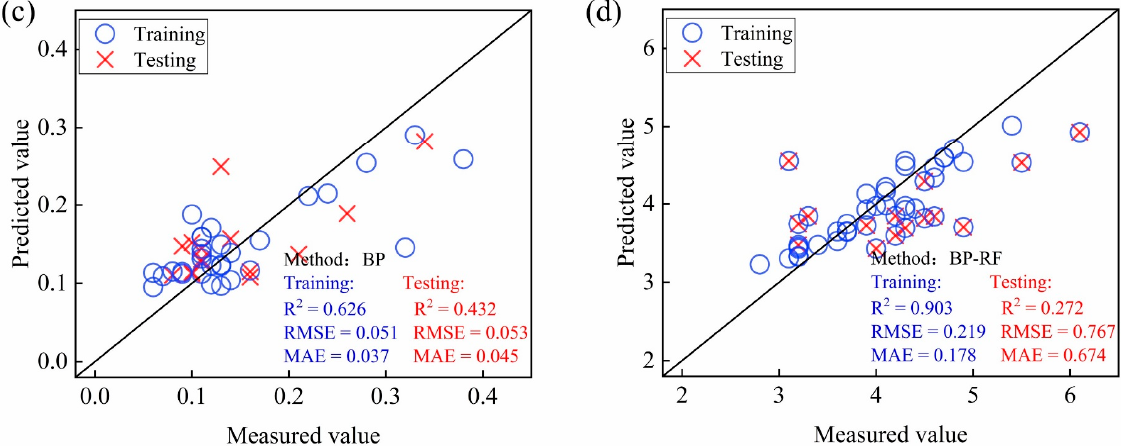
Figure 7. Scatter plots of measured water quality values and optimal model predicted values: ( a ) Chl-a, ( b ) TN, ( c ) TP, and ( d ) COD Mn .